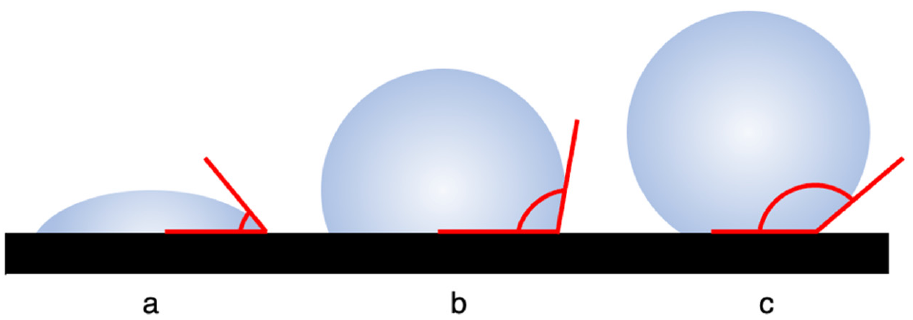
Figure 2. Schematic representation of wettability characterization: ( a ) hydrophilic contact angle (CA) less than 90°; ( b ) hydrophobic CA greater than 90°; ( c ) superhydrophobic CA greater than 150°. Note: This diagram is not designed to show surface roughness beneath the droplets.